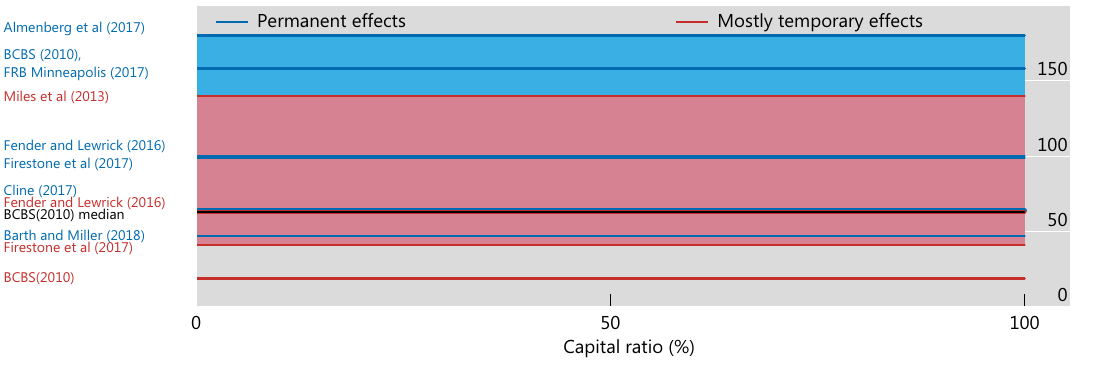
Figure 6. Cost of crisis (discounted, per cent of annual GDP).